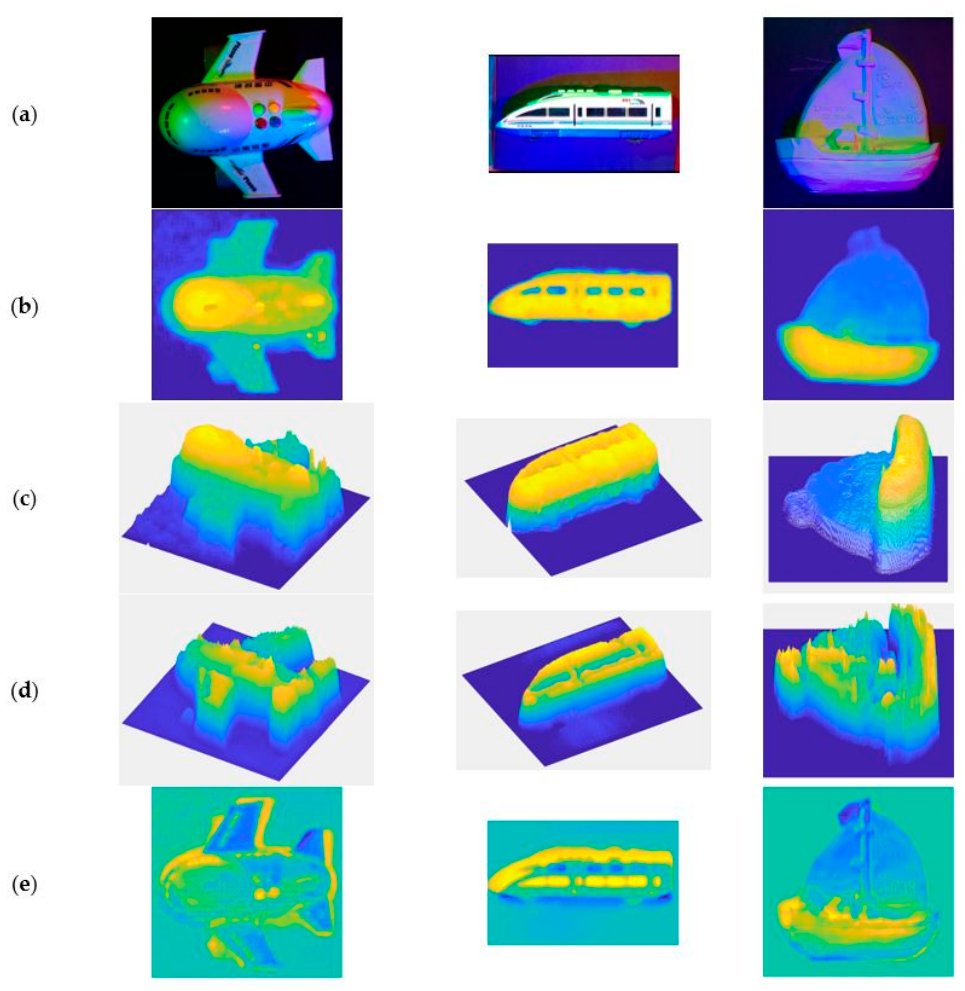
Figure 8. ( a ) The input image. ( b ) The approximate ground truth depth images after processing. ( c ) The 3D representation of ( b ). ( d ) The 3D representation of the result of our deep convolutional neural network (DCNN) and multi-spectral photometric stereo (DCNN+MS-PS) method. ( e ) The error map between ( c , d ).